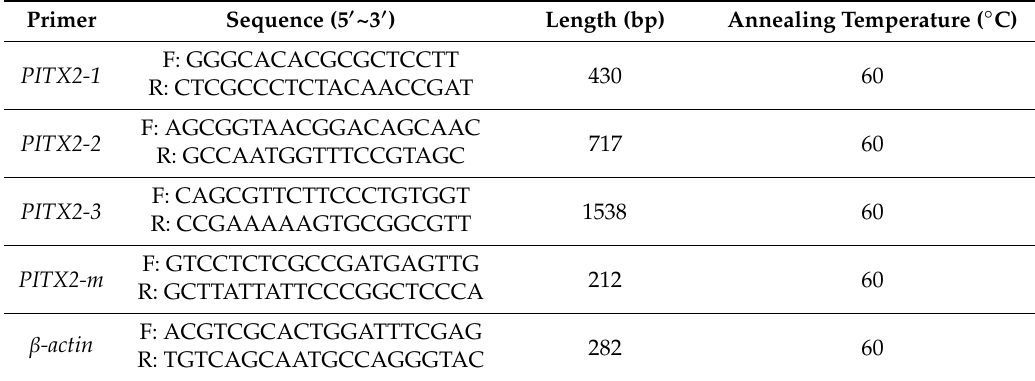
Table 1. Primers sequences for amplifying the exons and detecting the expression levels of paired-like homeodomain transcription factor 2 (PITX2) in